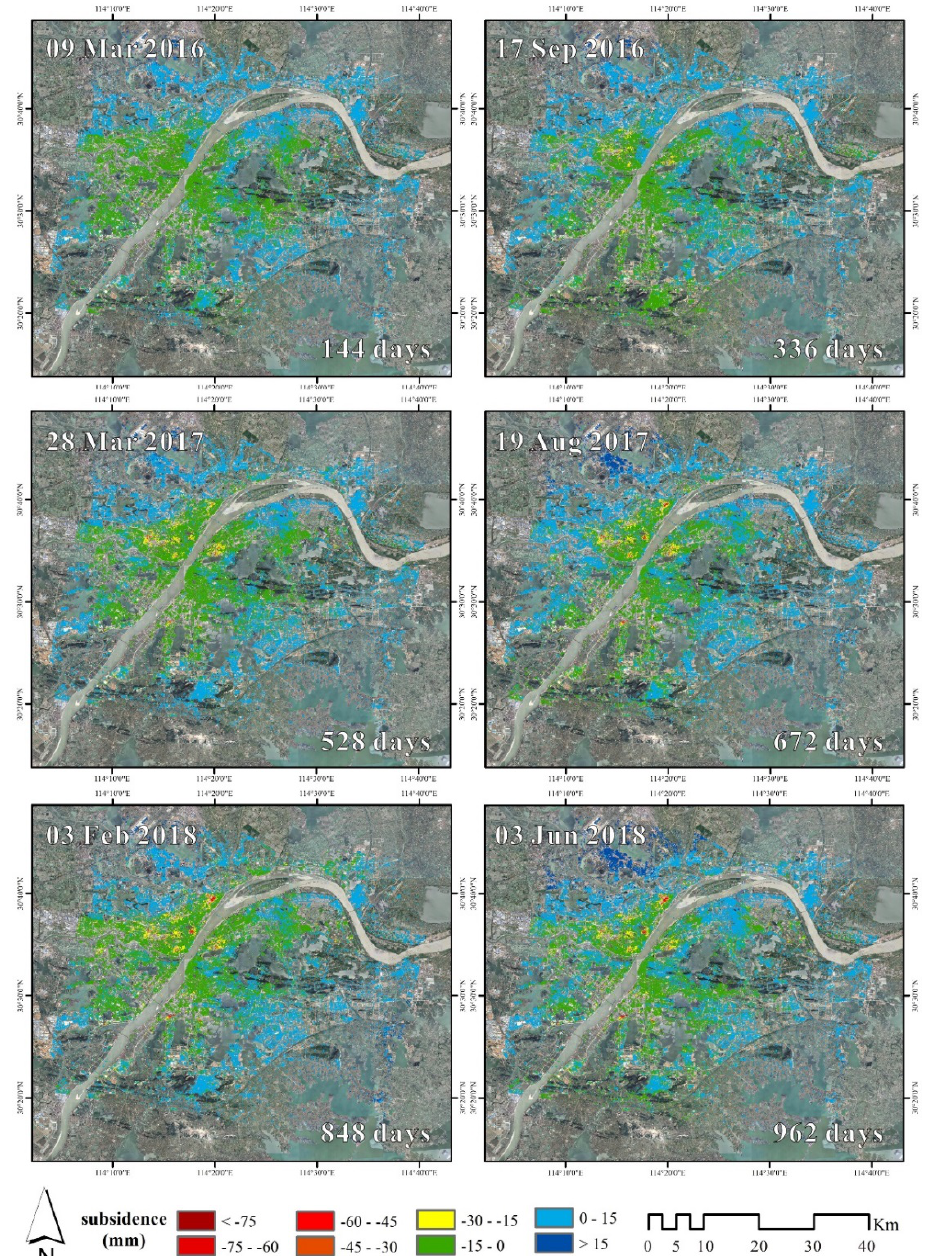
Figure 5. Spatio-temporal evolution of accumulated subsidence in Wuhan city derived from Radarsat-2 images. Only 6 of the 20 subsidence maps are shown.